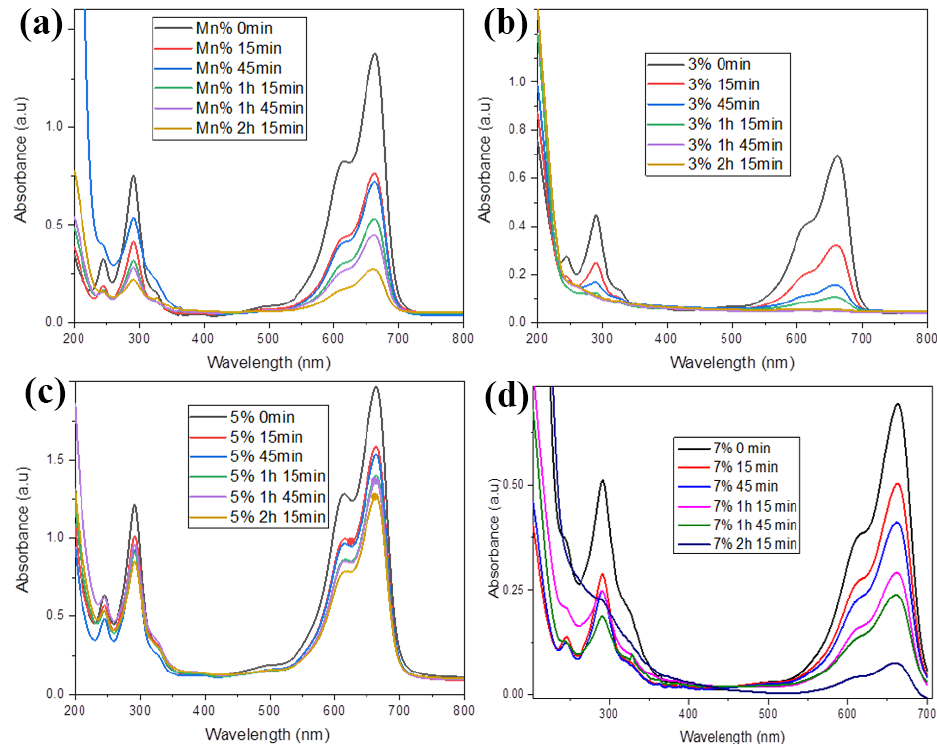
Figure 7. Photocatalytic assessment at different time intervals of ( a ) MnFe 2 O 4 , ( b ) 3%S@Mn(Fe 2 O 4 ), ( c ) 5%S@Mn(Fe 2 O 4 ), and ( d ) 7%S@Mn(Fe 2 O 4 ). ( c ) 5%S@Mn(Fe 2 O 4 ), and ( d ) 7%S@Mn(Fe 2 O 4